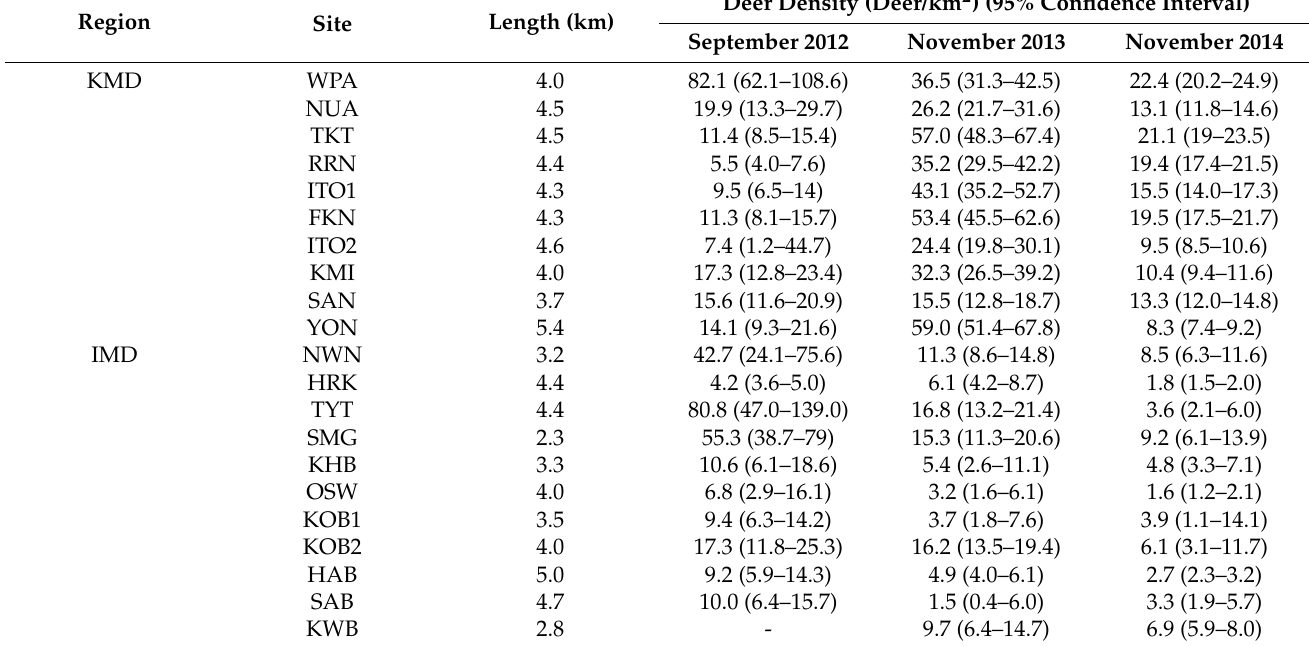
Table A1. Estimated deer density and the confidence interval at each site in Kushiro